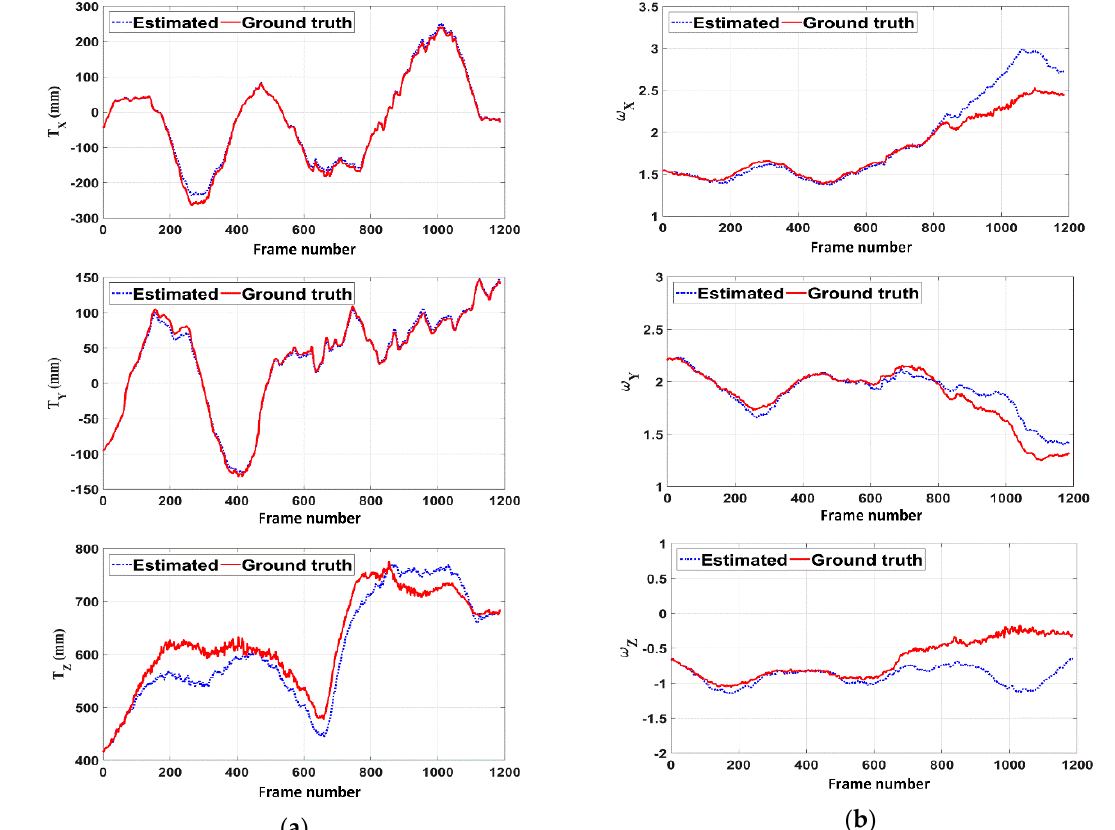
Figure 6. Components of estimated and ground truth camera pose: ( a ) Camera position part; ( b ) camera rotation part.